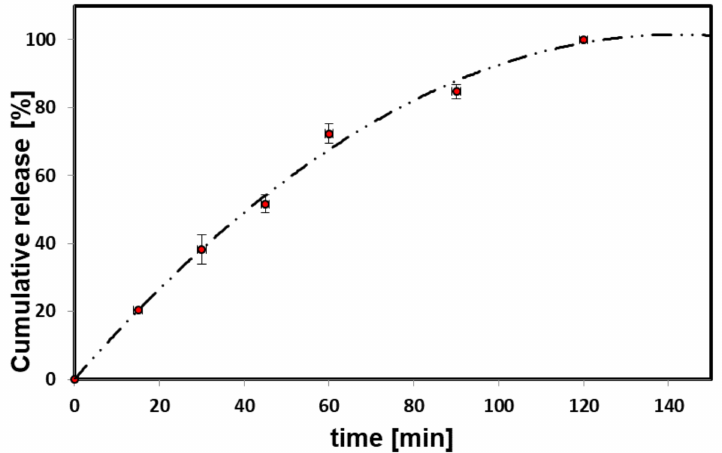
Figure 8. Piroxicam release profile (37 ◦ C, pH = 7) from 4:1 C-PUL / DEX-A nanohydrogel. The error bars represent mean and standard deviations of the single experiments ( n =